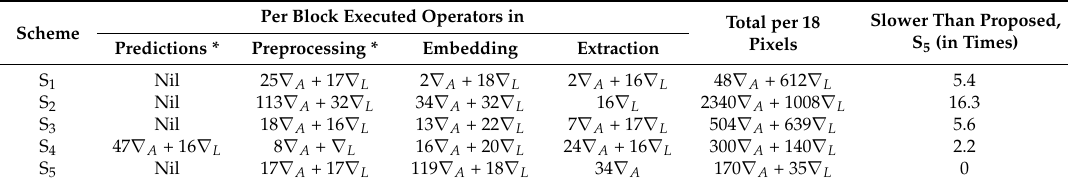
Table 4. Comparisons regarding executed arithmetic and logical